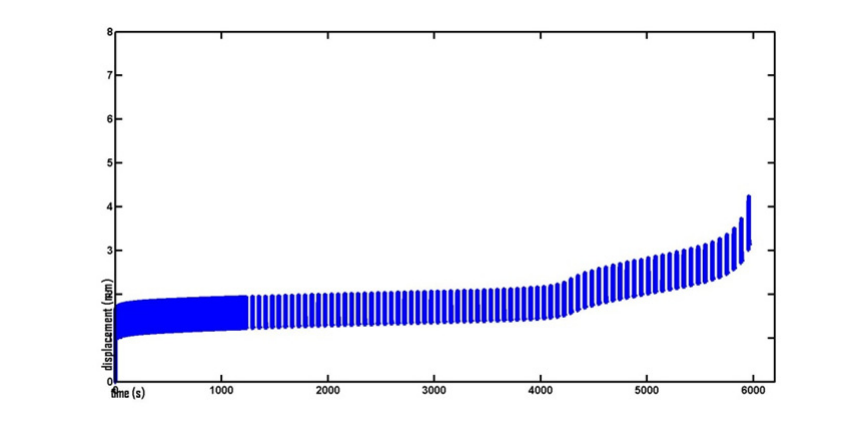
Fig. 10 Results of full test at 40 ⁰ C with a hold time of 2s